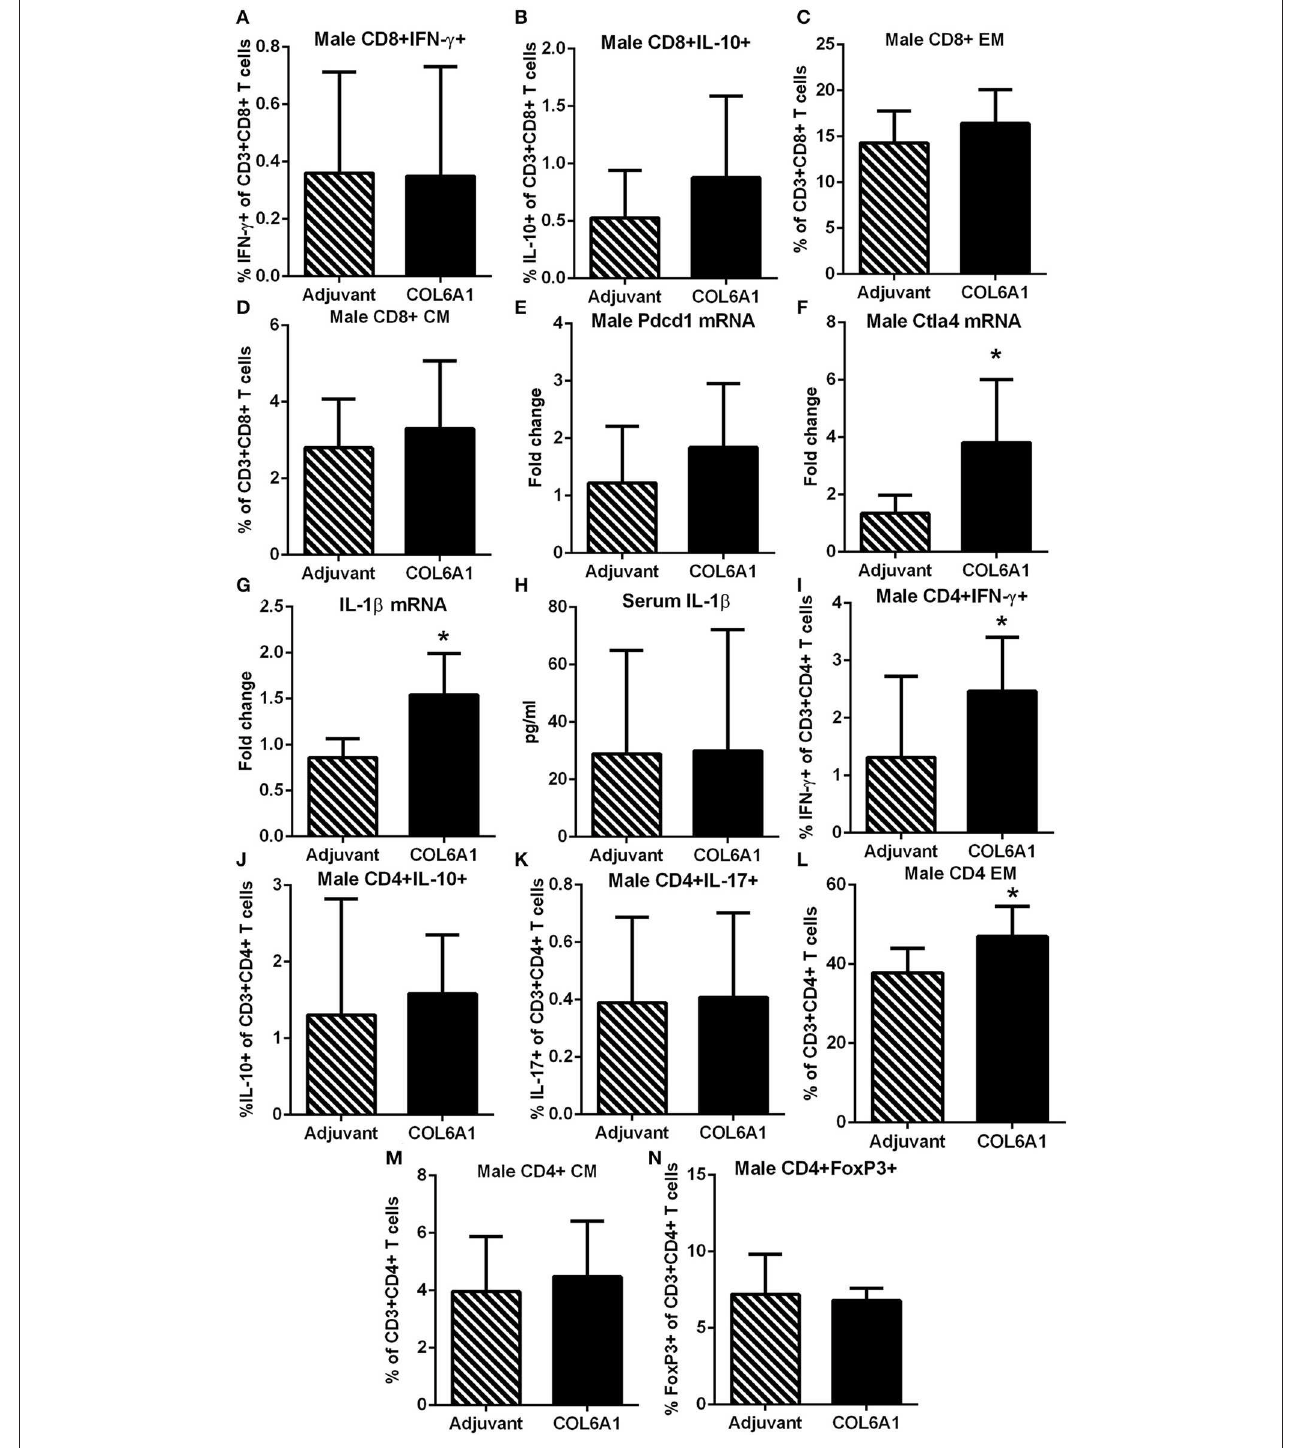
FIGURE 9 | Immune profile of male apoE–/– mice immunized with COL6A1. Intracellular staining of CD8 + T cells in splenocytes from male mice immunized with COL6A1 [ (A,B) ; N = 7–11 each]. Splenocytes were also stimulated with COL6A1 peptide for 48h and stained for Effector Memory (EM) and Central Memory (CM) CD8 + T cells [ (C,D), respectively; N = 7–8 each]. Pdcd1 and Ctla4 mRNA expression in spleens of male mice [ (E,F) ; N = 5 each]. IL-1 β mRNA expression in spleens [ (G) ; N = 5 each] and IL-1 β in serum [ (H) ; Adjuvant N = 4, COL6A1 N = 7]. Intracellular staining of CD4 + T cells (I–K) , EM and CM CD4 + T cells [ (L,M) , respectively], and CD4 + FoxP3 + T cells (N) . * P < 0.05; T- test. Gating scheme for flow cytometric analysis as depicted in Figure S1 for cytokine stain, Figure S2 for Memory T cells and Figure S4 for CD4 + IL-17 + T